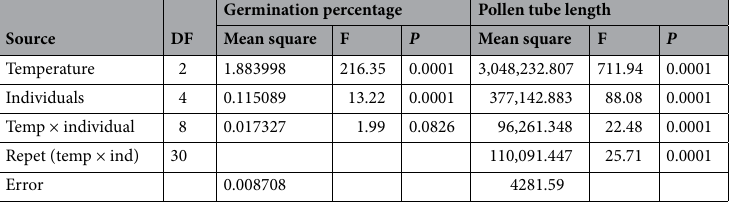
Table 1. Analysis of variance of juniper pollen germinability and pollen tube length in fresh and stored